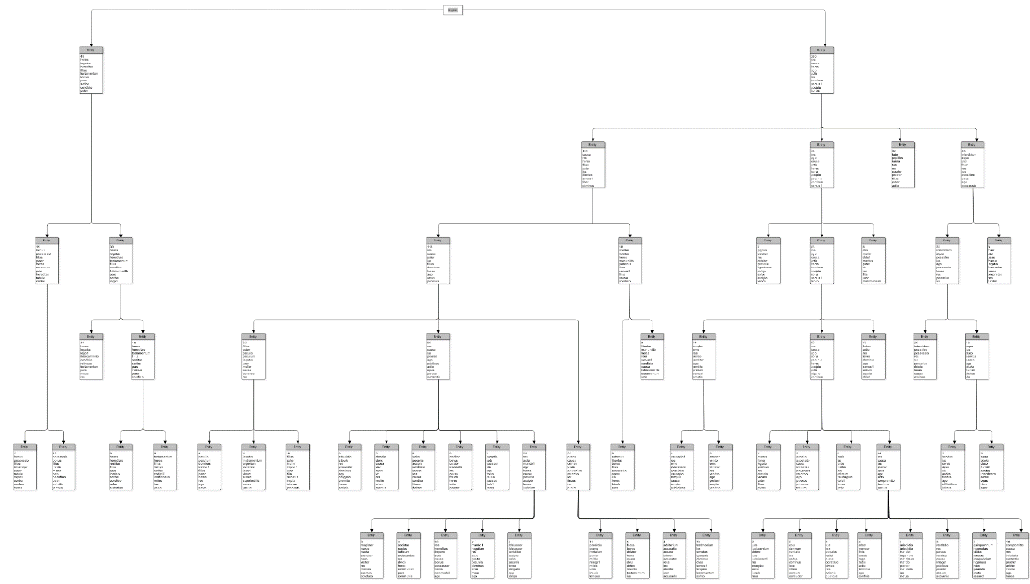
Figure 4. Empirical conceptual tree-map of Roman law based on thematic sections of the Digest.